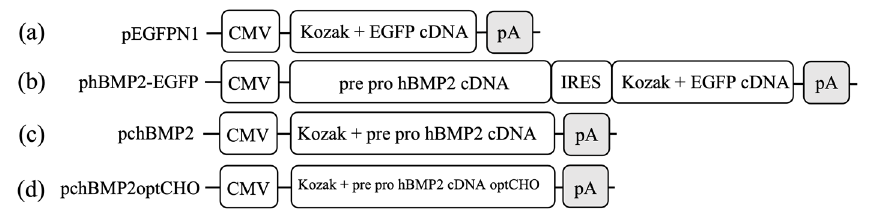
Figure 1. Expression cassettes of the plasmids used in this study. ( a ) pEGFP-N1, ( b ) phBMP2-EGFP, ( c ) pchBMP2, ( d ) pchBMP2optCHO. ( c ) pchBMP2, ( d )